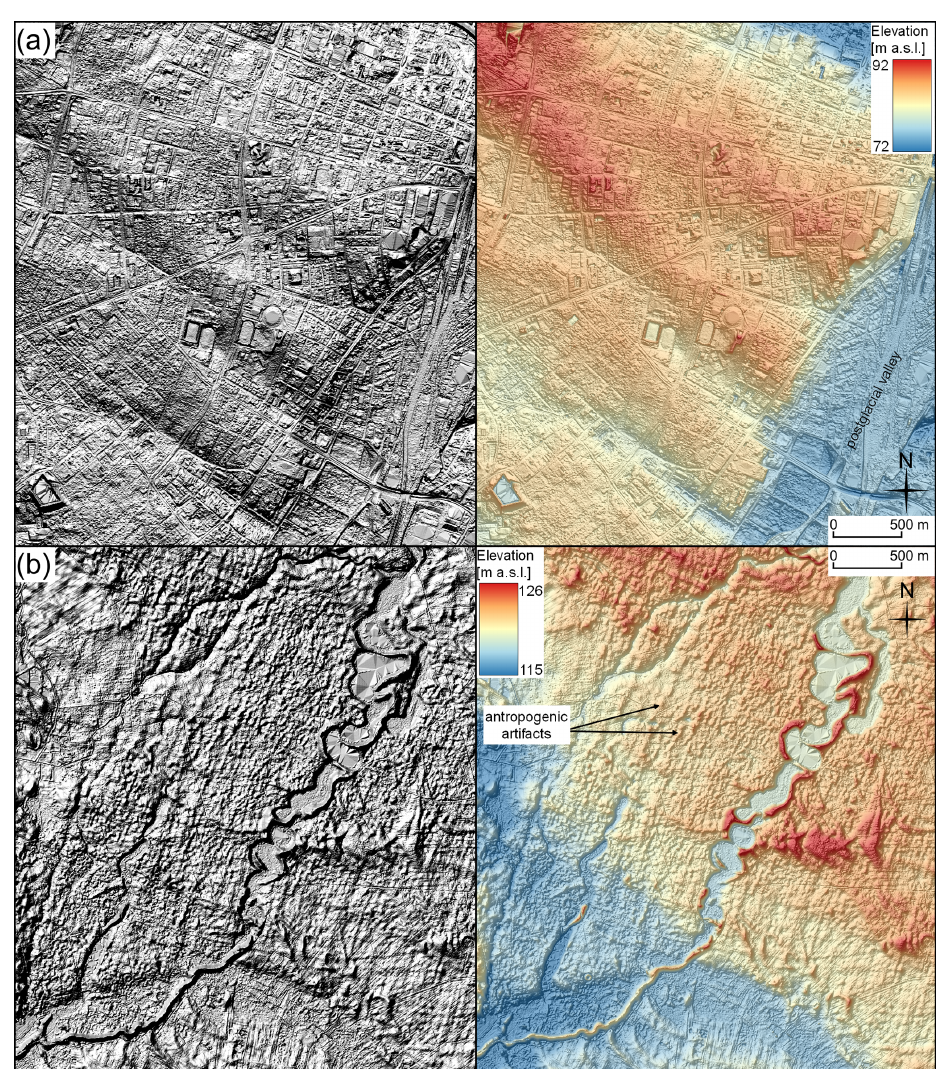
Figure 11. (a) Highly urbanised area on top of MSGLs interrupted by postglacial valley. Notice that the scale difference of the imprint for both groups results in small degradation potential. (b) There is an impression of delicate streamlined bedforms, which are in fact of anthropogenic origin. Ground truthing showed that they are forestry